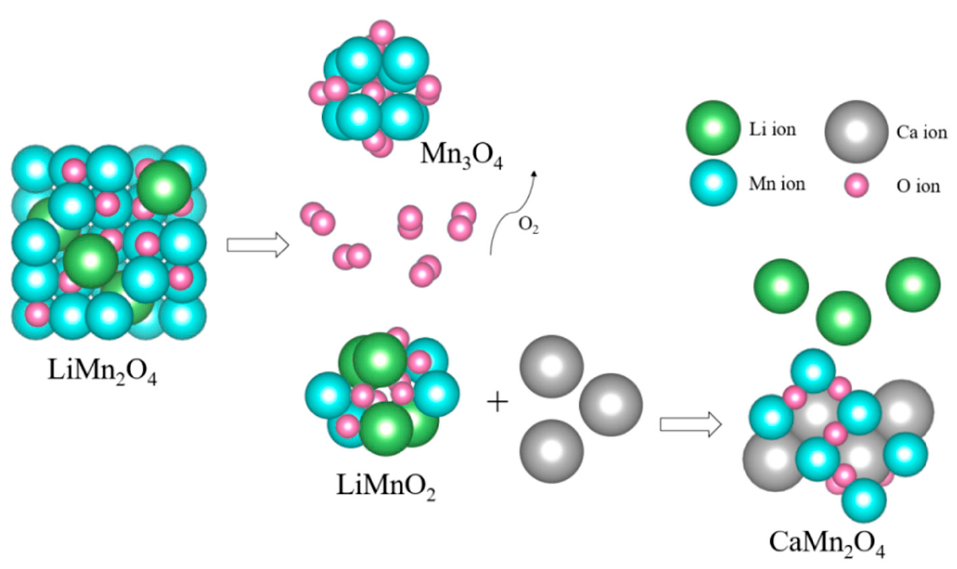
Figure 2. LiMn 2 O 4 and molten salt reaction process. 102